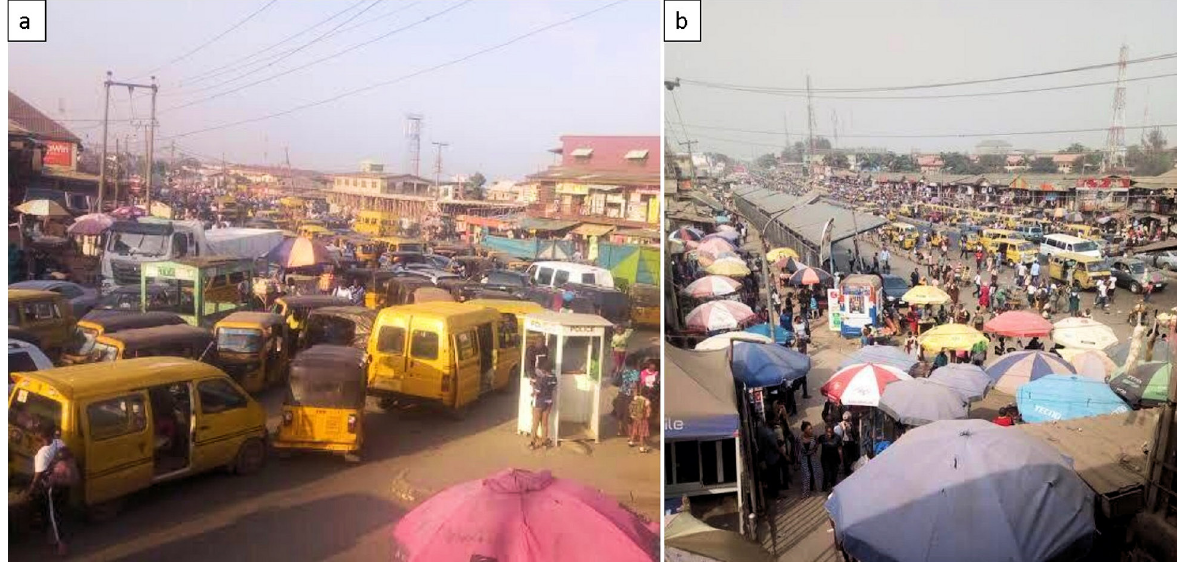
Fig. 9. Some parts of Alimosho LGA. a – Ikotun Bus stop/garage; b – Bus Rapid Transit (BRT) terminal along